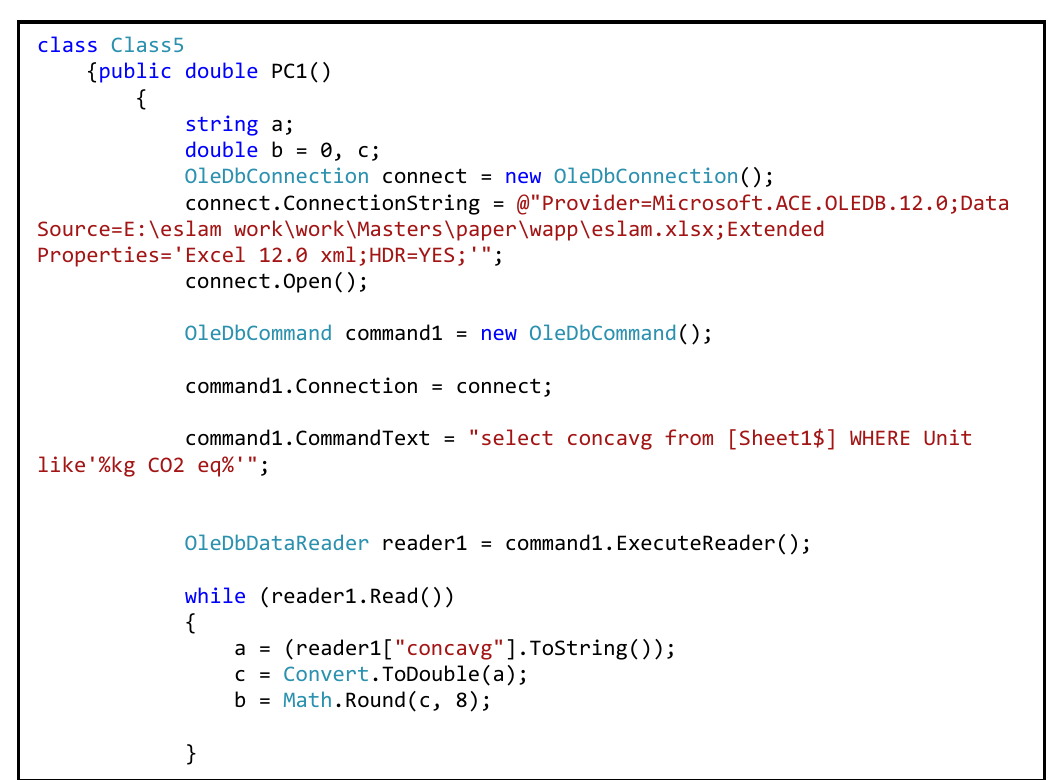
Fig. 4. Developed code to import data from Microsoft